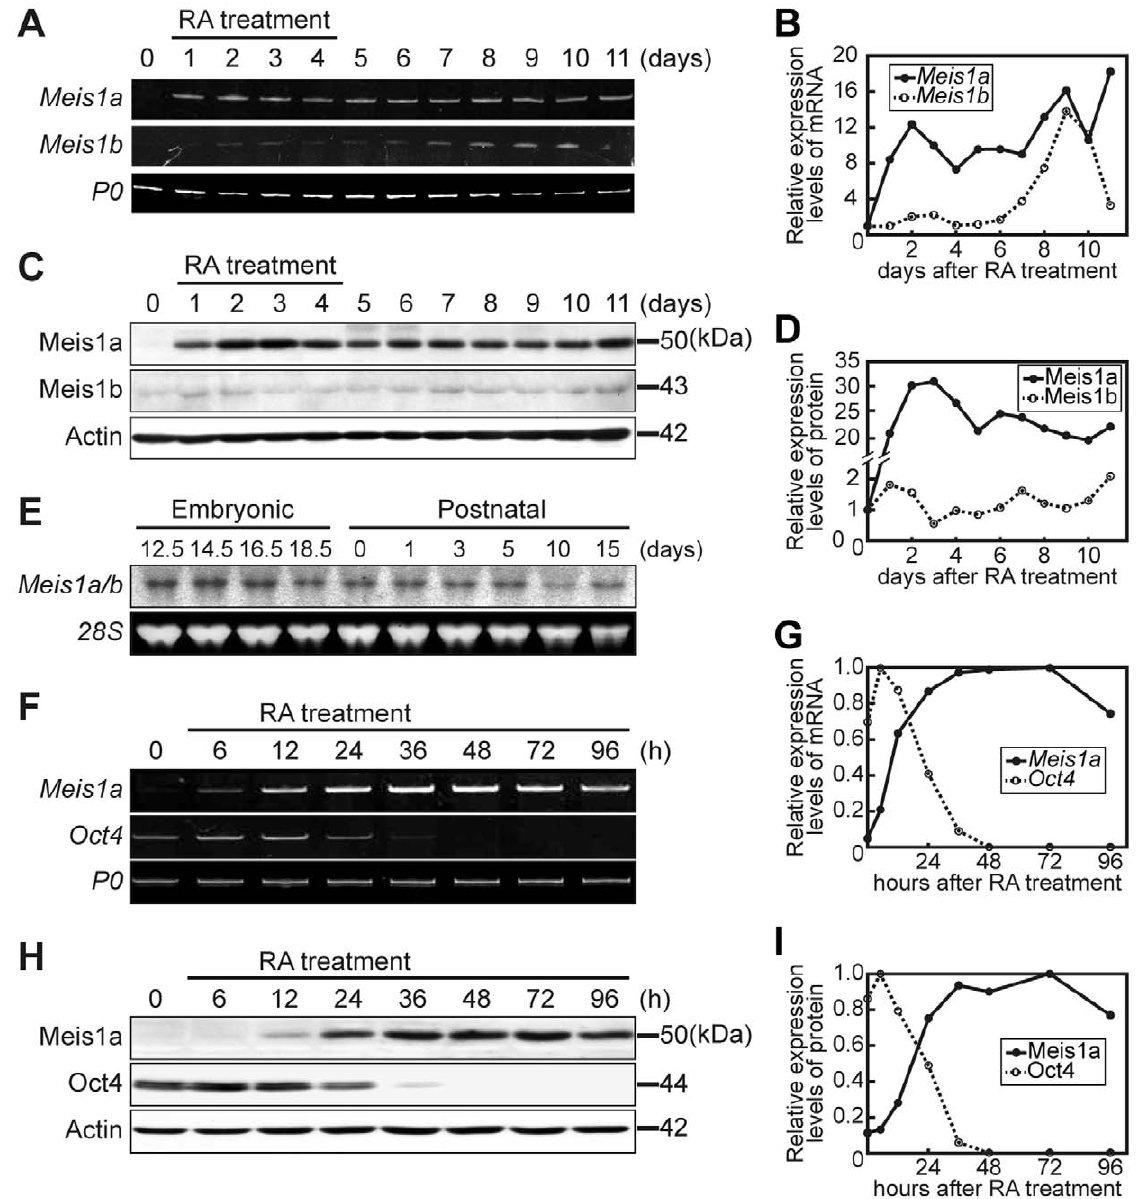
Figure 1. Induction of Meis1a/b expressions during neural differentiation of RA-primed P19 cells. Aggregated P19 cells were treated with 5 6 10 2 7 M RA for various times and the expression levels of Meis1a/b mRNAs and proteins were analyzed by RT-PCR and WB with the anti-Meis1 antibody, respectively. ( A ) Expression patterns of Meis1a and Meis1b mRNAs during neural differentiation. ( B ) Quantification of the expression levels of Meis1a and Meis1b mRNAs indicated in A . ( C ) Expression patterns of Meis1a and Meis1b proteins during neural differentiation. ( D ) Quantification of the expression levels of Meis1a and Meis1b proteins indicated in C . ( E ) Expression levels of Meis1a/b mRNAs in mouse fetal brain. Total RNAs from the developing brain were analyzed by Northern blotting. ( F ) Detailed expression patterns of Meis1a and Oct4 mRNAs during neural differentiation. ( G ) Quantification of the expression levels of Meis1a and Oct4 mRNAs indicated in F . ( H ) Detailed expression patterns of Meis1a and Oct4 proteins during neural differentiation. ( I ) Quantification of the expression levels of Meis1a and Oct4 proteins indicated in H . Ribosomal large subunit protein P0 mRNA, b -actin and 28S ribosomal RNA were used as internal controls.